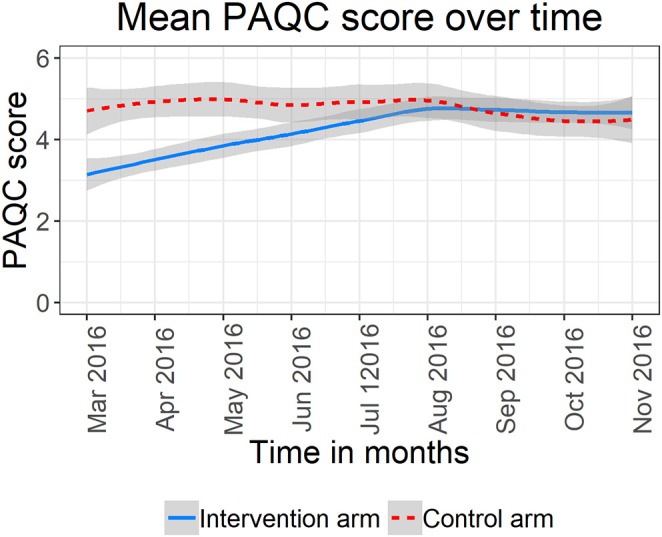
Mean PAQC score and 95% confidence bands for six hospitals in the standard A&F arm and six hospitals in the enhance A&F arm.